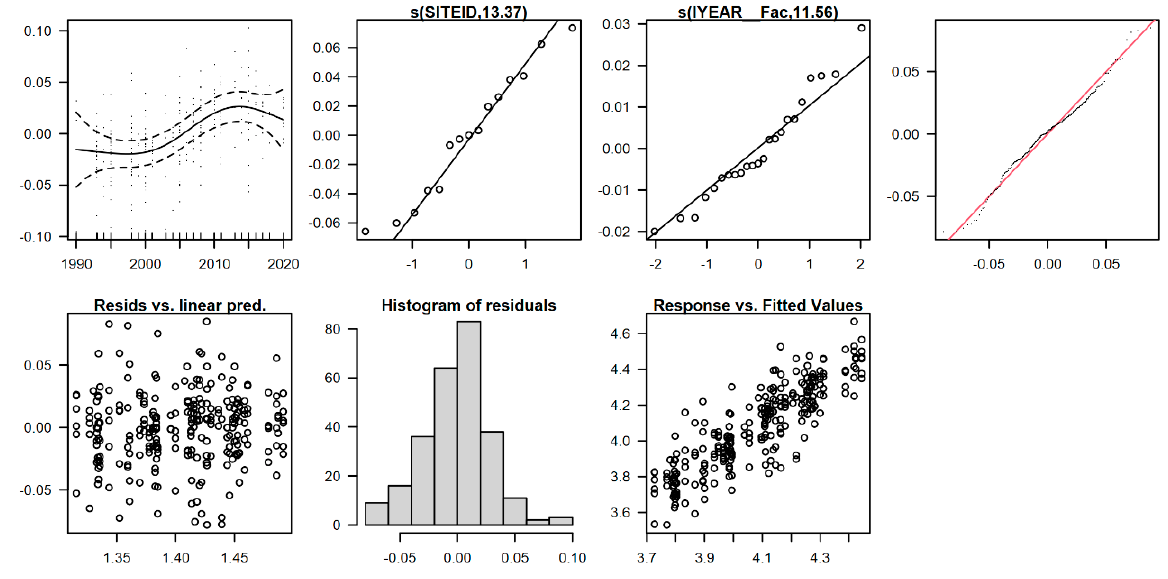
Soil Syst. 2022 , 6 , x FOR PEER REVIEW 22 of 26 Figure A3. Example of graphical residual analysis (normality; homogeneity) of the selected general- ized additive mixed model (GAMM) for pH(H 2 O) values at unlimed plots in a 0–30 cm soil depth.